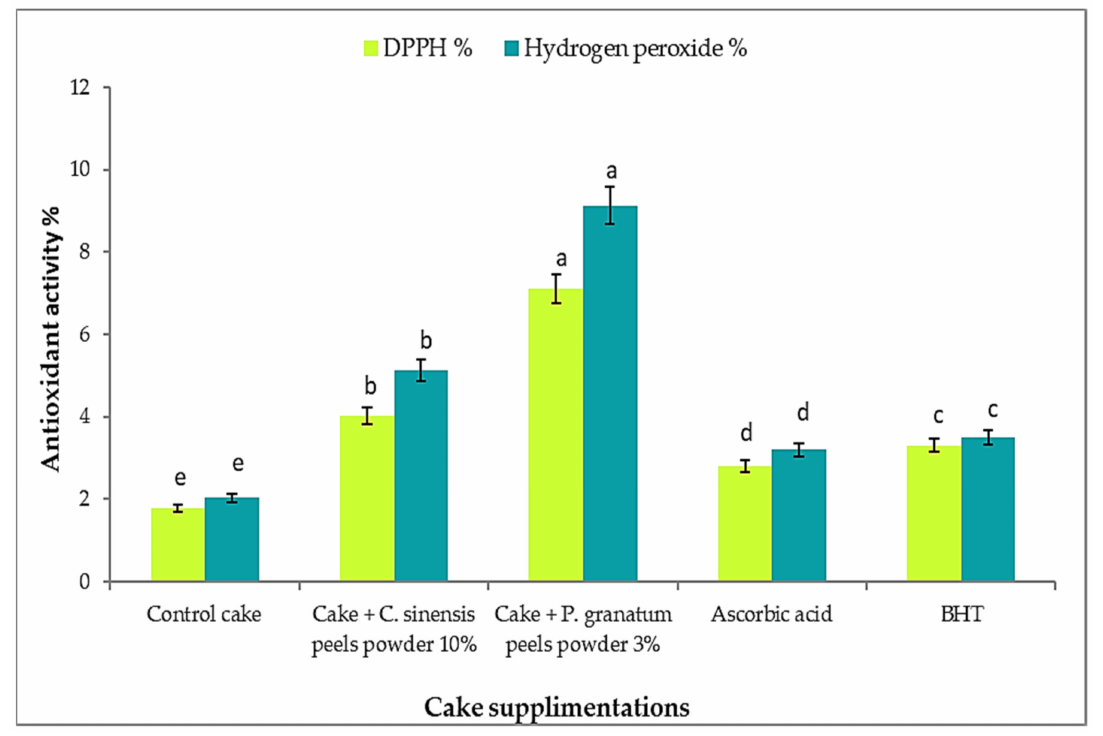
Figure 11. Antioxidant activity of cake supplemented with C. sinensis 10% and P. granatum 3% peel powder against DPPH • and hydrogen peroxide. Each value is a mean ( ± SD) of three replicates. The different letters on the same bar show a significant difference according to Duncan’s test at p ≤